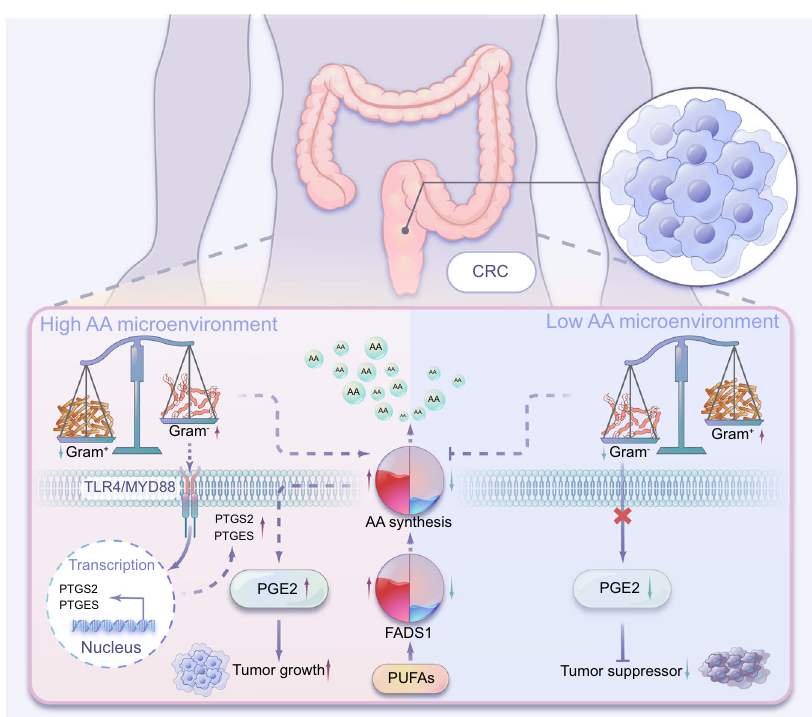
Fig. 8 | The mechanism diagram of this study. FADS1-AA axis in CRC cells that modulate the intestinal microecology of enriched gram-negative bacteria via creating a high AA microenvironment. Enriched gram-negative microecology accelerated AA converting to PGE2 and eventually promotes CRC